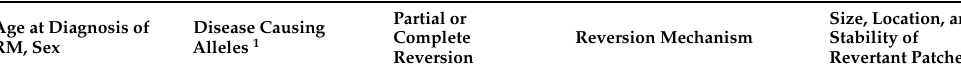
Table 1. Published cases of revertant mosaicism in EB